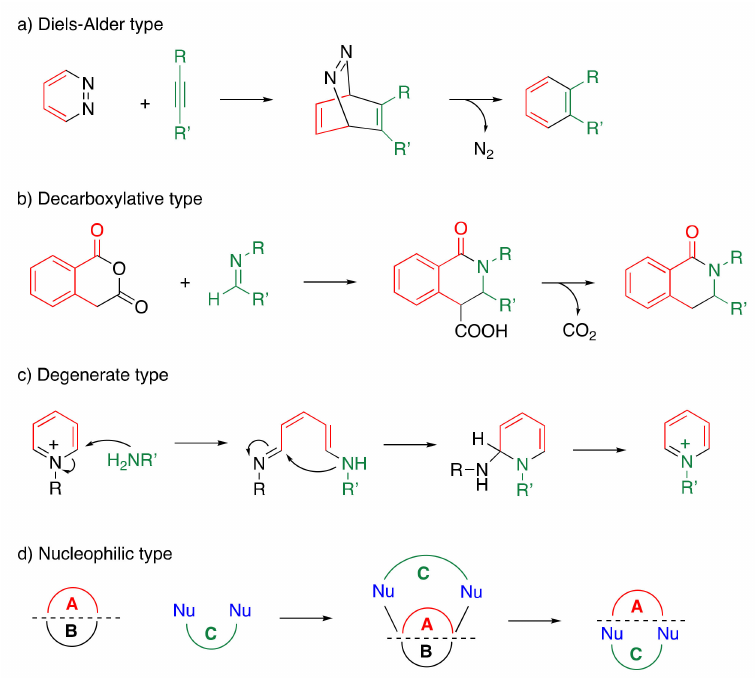
Scheme 2. General concepts of four kinds of ring transformations.